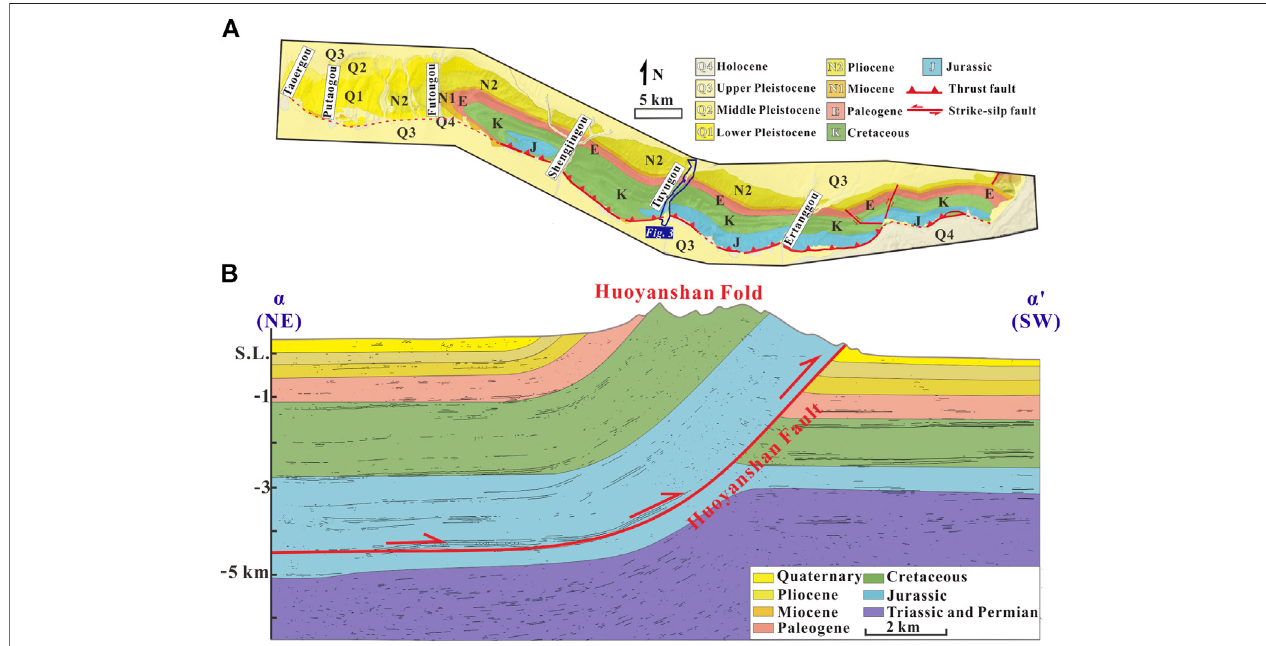
FIGURE 2 | (A) Simpli fi ed geologic map of the Huoyanshan structure (modi fi ed from Peng, 1995, see Figure 1C for the location) (B) Geologic cross-section α - α ’ (see Figure 1C for the location of α - α ’ ) of the Huoyanshan structure, interpreted from Deng et al., 2000; Yao et al., 2013 ; and Chang, 2016.